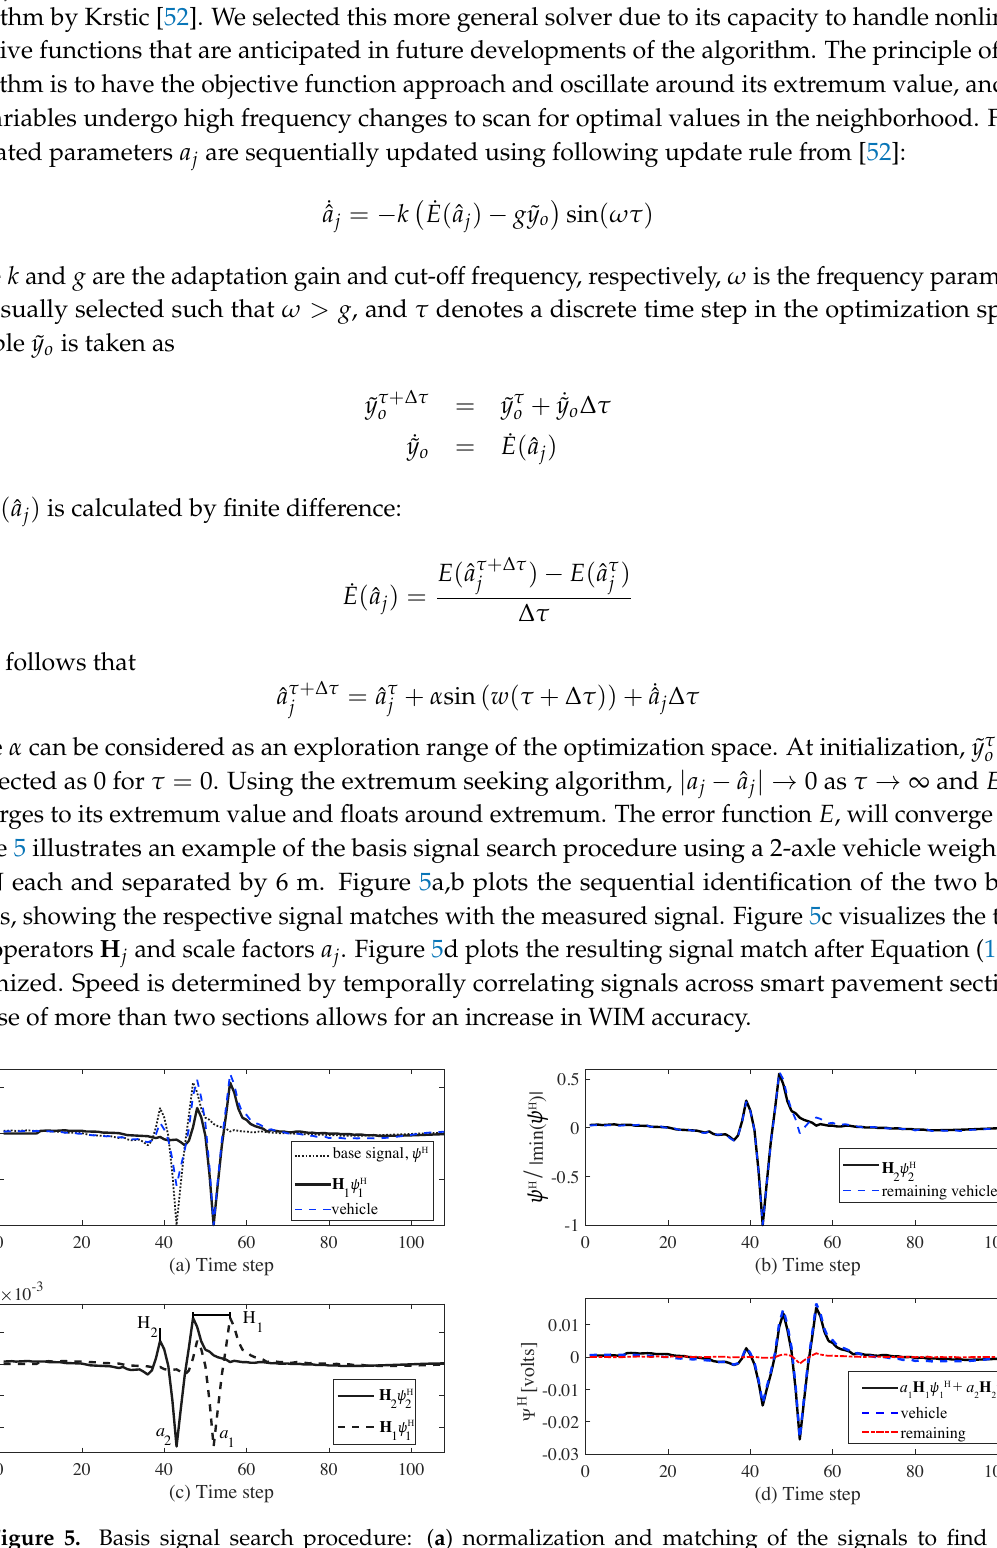
Figure 5. Basis signal search procedure: ( a ) normalization and matching of the signals to find the first basis signal H 1 ψ H ; ( b ) matching of remaining signal to find the second basis signal 1 H 2 ψ H ; ( c ) visualization of time shift operators H 1 and H 2 , and scale factors a 1 and a 2 ; and ( d ) 2 reconstructed